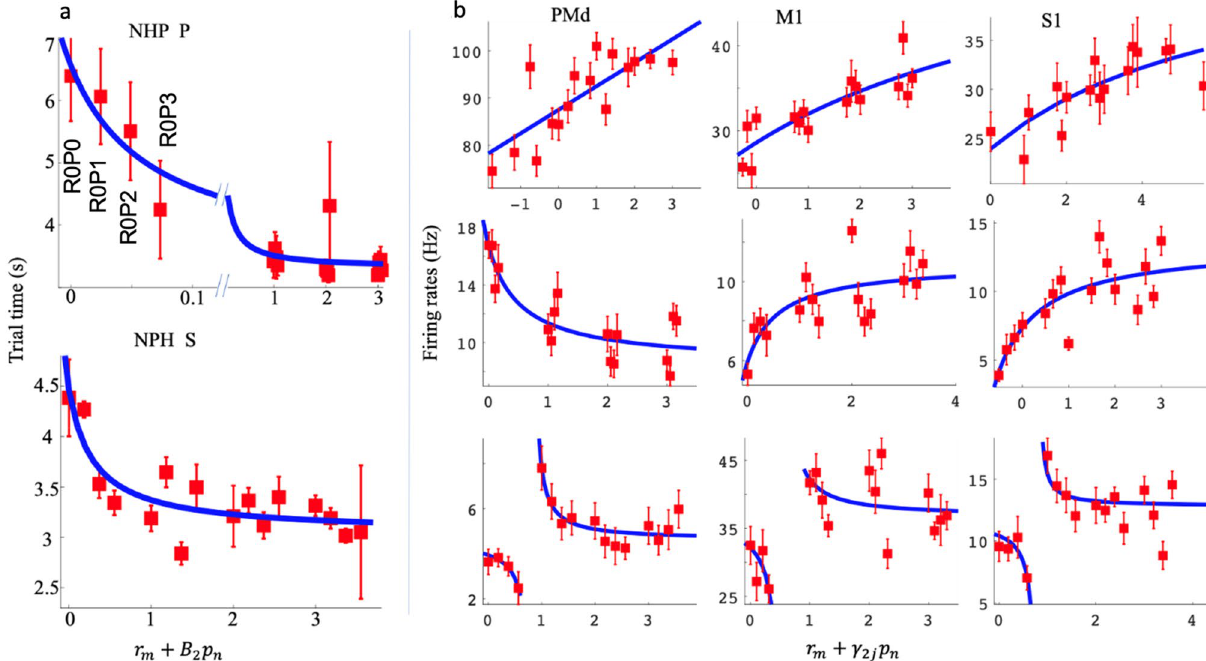
Figure 3. Post-cue reward (R) and punishment (P) analysis with divisive normalization model 2. ( a ) depicts the average and SEM of the trial time (red) for different affective stimuli. The x-axis represents the R and P level in the form of an affective stimulus r ( i ) + B 2 p ( i ) , and the y-axis represents the trial time (s). We have labeled the R and P levels for the R = 0 group. ( b ) shows example unit R and P modulation for post-cue neural spike data. Each unit has an R and P encoding model 2 significantly different from a constant model (F-test, p < 0.05). For each subplot, the x-axis represents the affective stimulus as above, and the y-axis represents the post-cue firing rate (Hz). Each red point represents the mean post-cue firing rate (0–500 ms post cue onset) for that R and P level ± the SEM, and the blue line represents model 2 fit to that unit’s data. The first column includes units from PMd, the second column M1, and the third column S1. The rows from top to bottom show examples of linear, sigmoidal, and hyperbolic units.